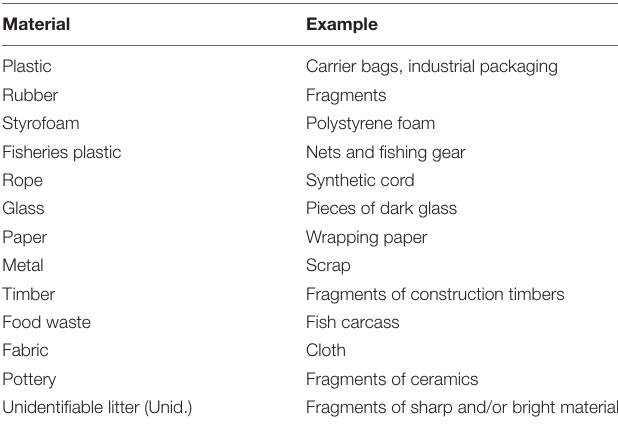
TABLE 1 | Categories of material